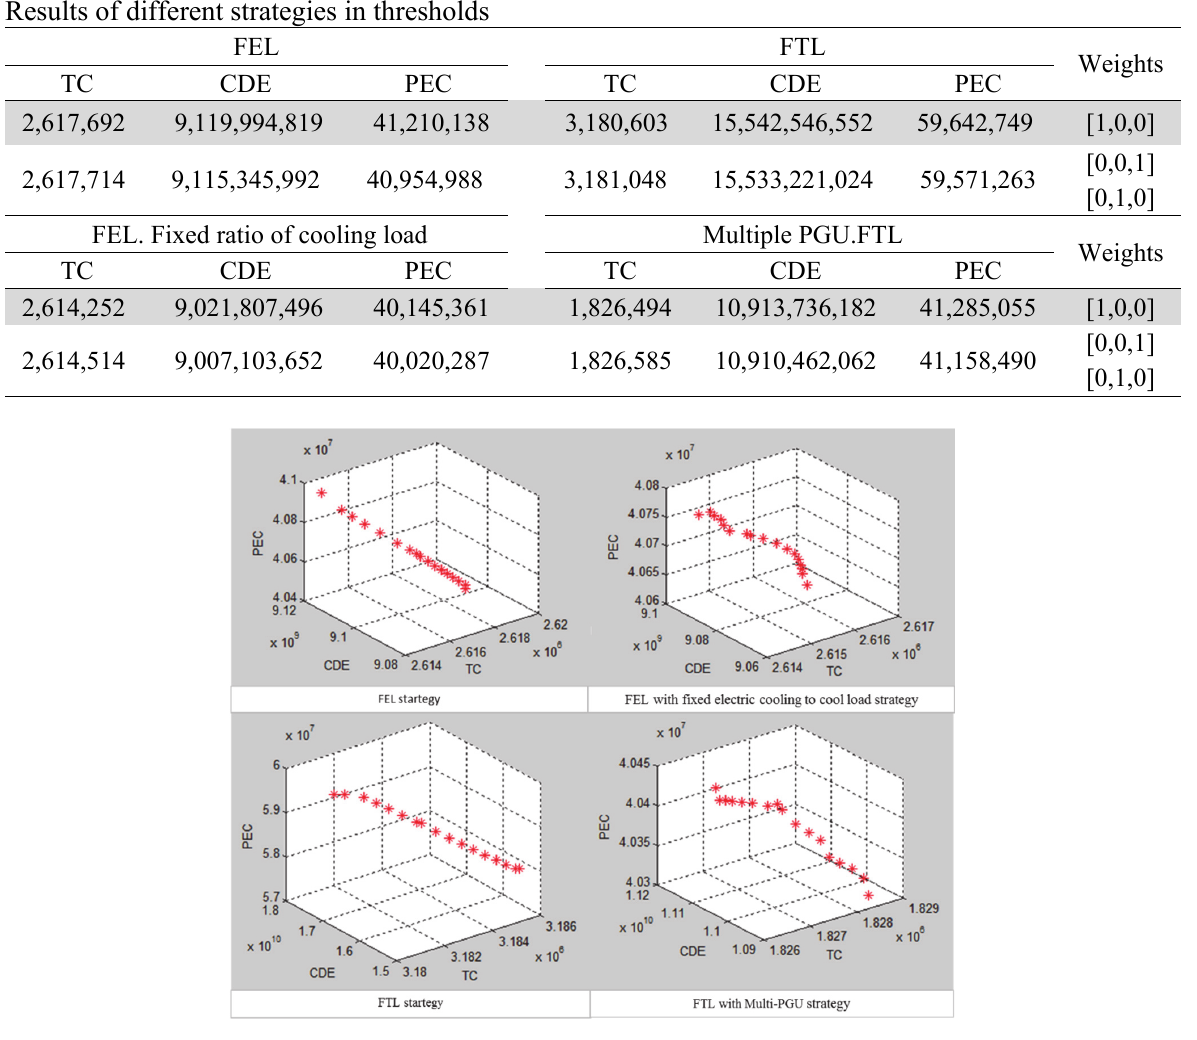
Fig. 6. Objectives amount for different strategies in different